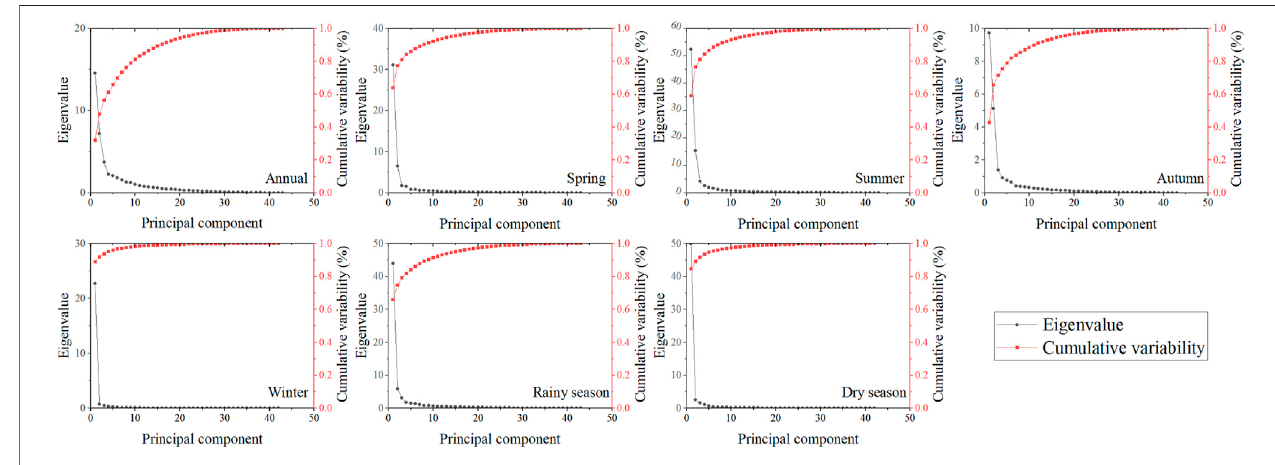
FIGURE 5 | Scree plots of the SPEI at various time scales on the